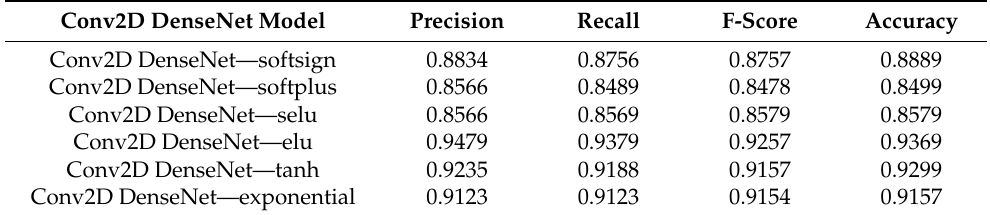
Table 7. Performance analysis for Conv2D DenseNet model with various activation